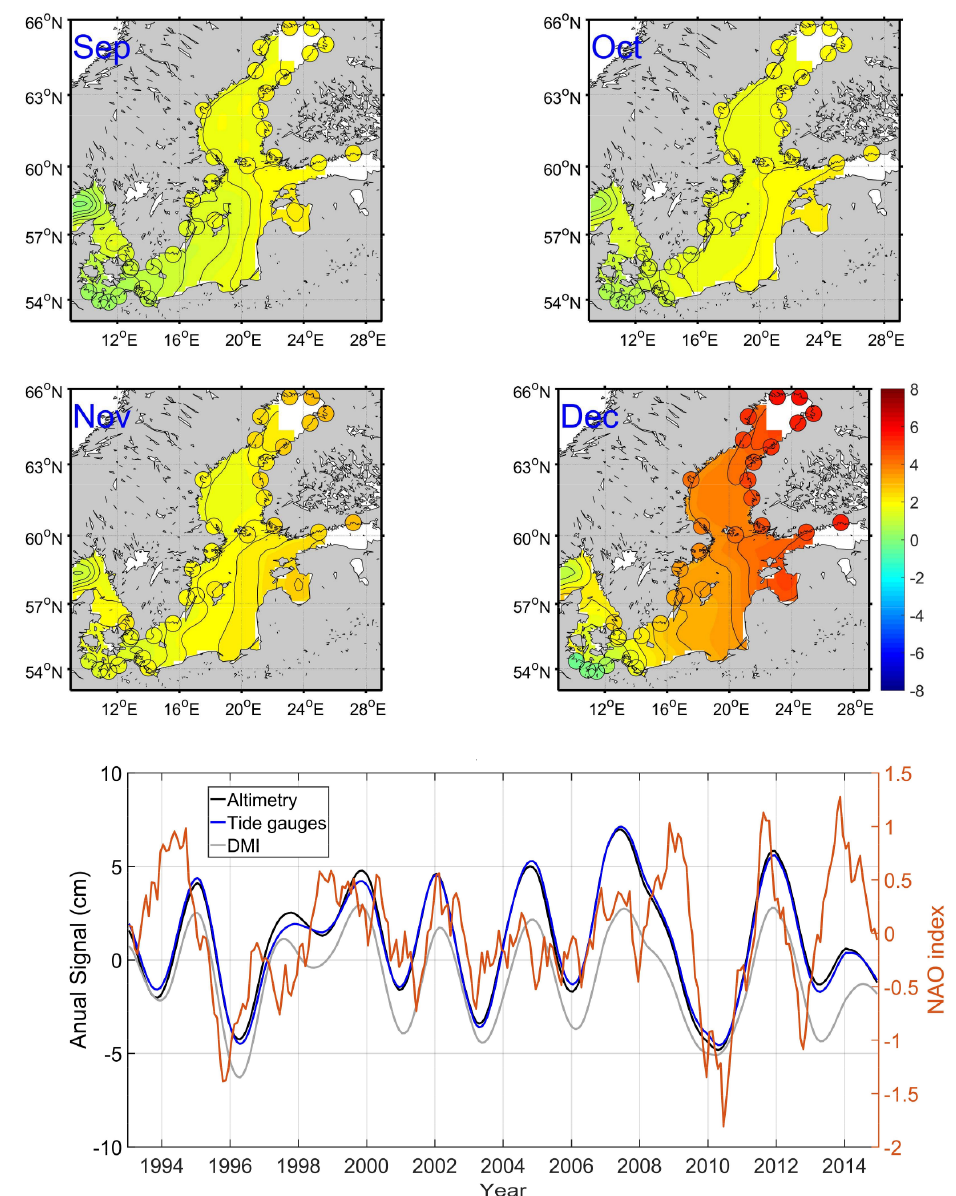
Figure 4. The first cyclostationary empirical orthogonal function (CSEOF) mode captures the spatial patterns (color images) and temporal variations (time series) of the annual sea level cycle: monthly time-dependent loading vectors (LVs) (cm, January to December) computed from satellite altimetry and tide gauge data and the principal component (PC) time series (PC1, dimensionless) of altimetry data (black line), tide gauge data (blue line) and SMHI model reanalysis (gray line) for 1993–2014. The 13-month running mean filtered station-based North Atlantic Oscillation (NAO) index (red line) is overlaid. Each PC is normalized by its mean value and the LV is multiplied by the